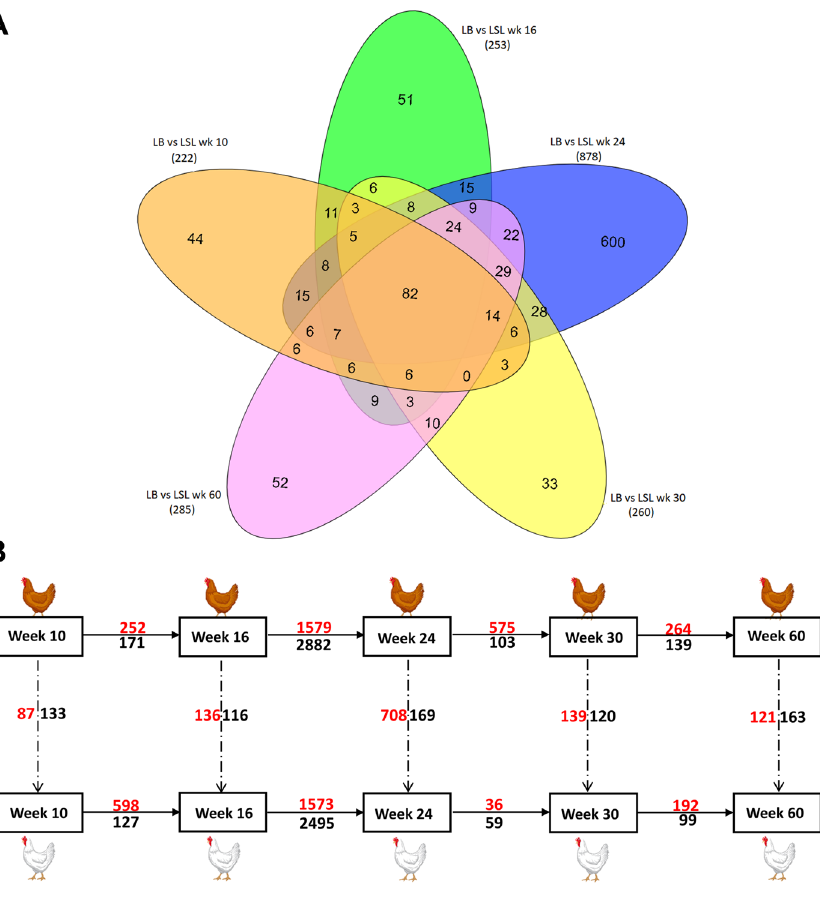
Figure 2. Number of DEGs derived from jejunal mucosa related to selected production stages in LB and LSL laying hens. ( A ) Venn diagram depicting the differentially expressed genes between LB and LSL for each production stage (week 10, 16, 24, 30 and 60) as well as their overlaps among different production stages. The total number of stage-specific DEGs is given in brackets. ( B ) Comparisons of DEGs within (horizontal) and between (vertical) each of the two laying hen strains across the selected production stages. Values in red and black represent numbers of upregulated and downregulated DEGs. LB—Lohmann Brown; LSL—Lohmann Selected